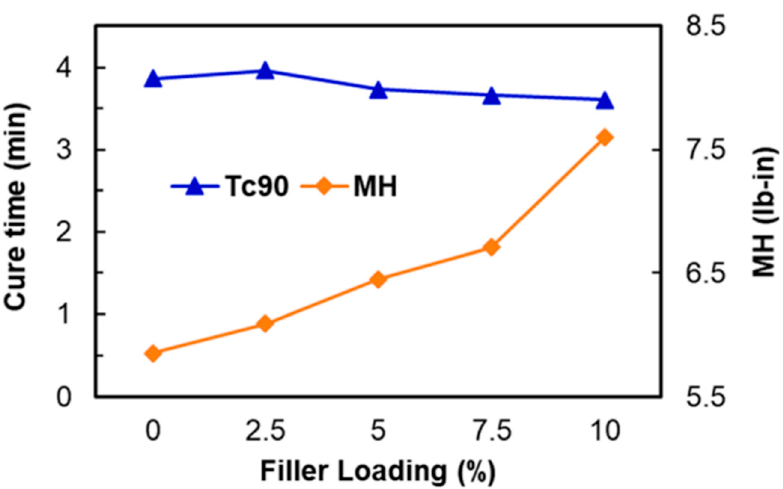
Figure 11. Curing characteristics of NR nanocomposites reinforced with CNC at different concentrations (reproduced with permission from [124]).